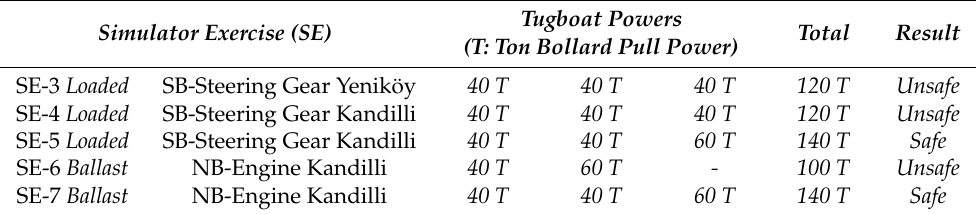
Figure 5. Comparisons of cruising speeds for northbound and southbound passages. Table 4. Tugboat efficiency evaluation